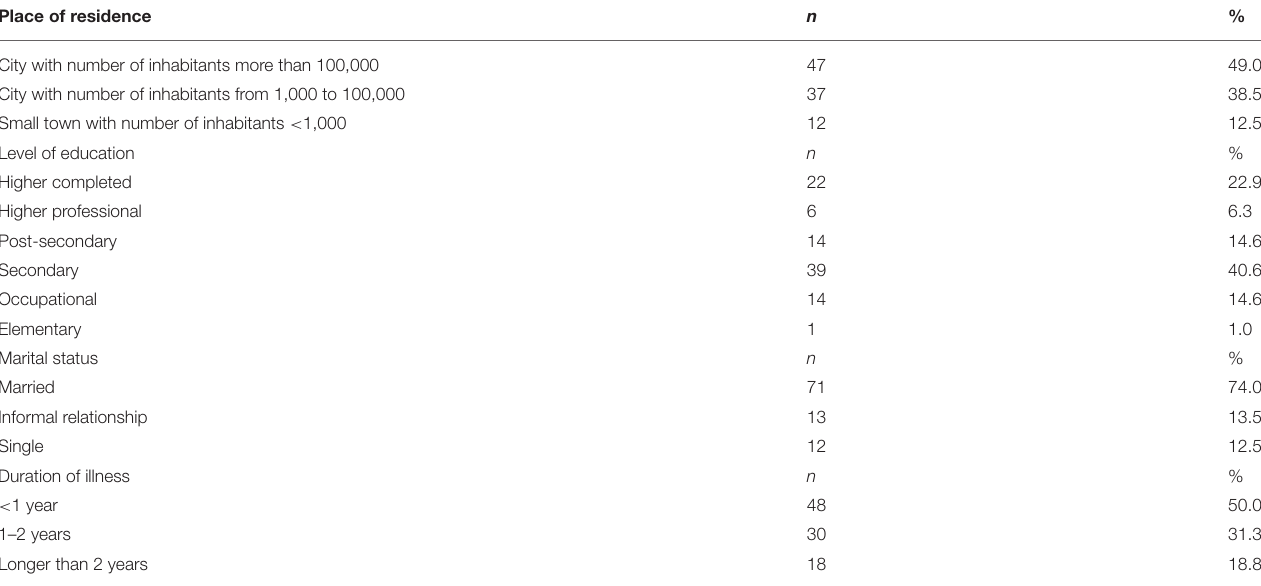
TABLE 1 | Frequency distribution—place of residence, educational level and marital status, and duration of illness. Place of residence n City with number of inhabitants more than